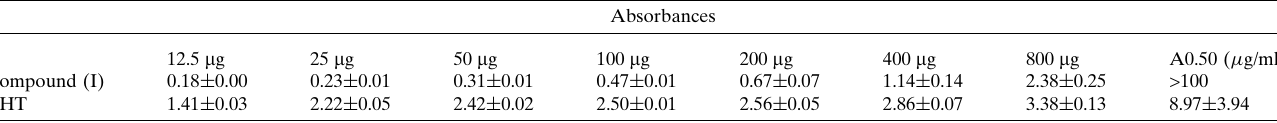
Table 3 Cupric ion reducing antioxidant capacity of compound (I).